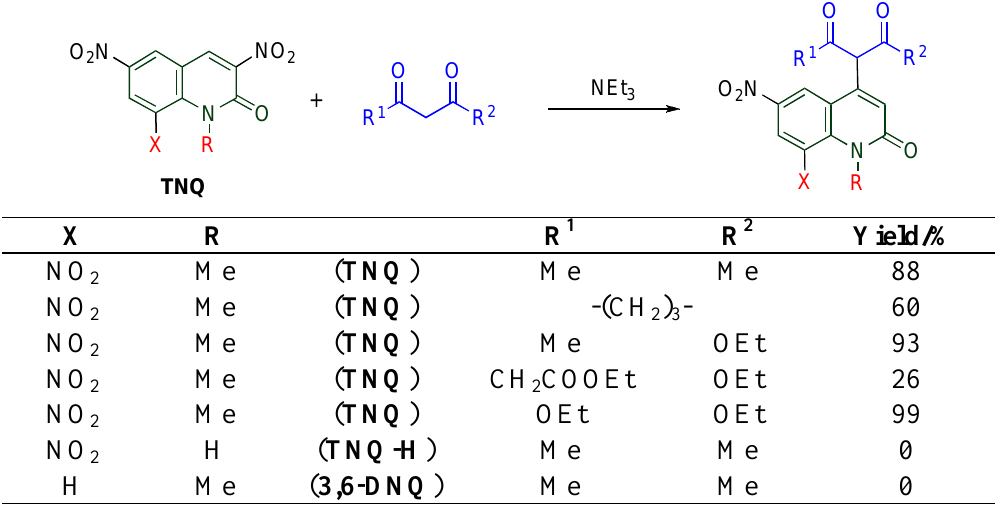
Table 8. Reactions of nitroquinolones with 1,3-dicarbonyl compounds.